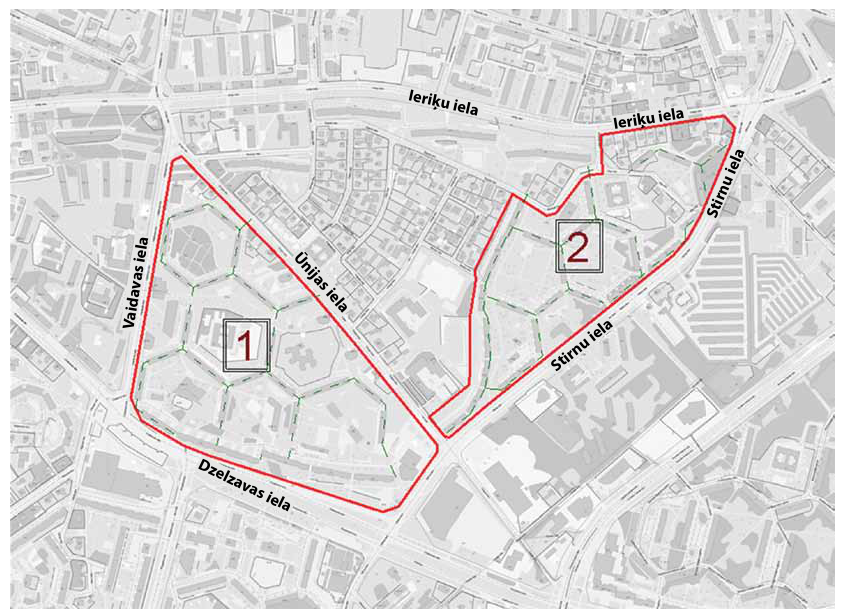
Fig. 8. Sites of the research in northern part of